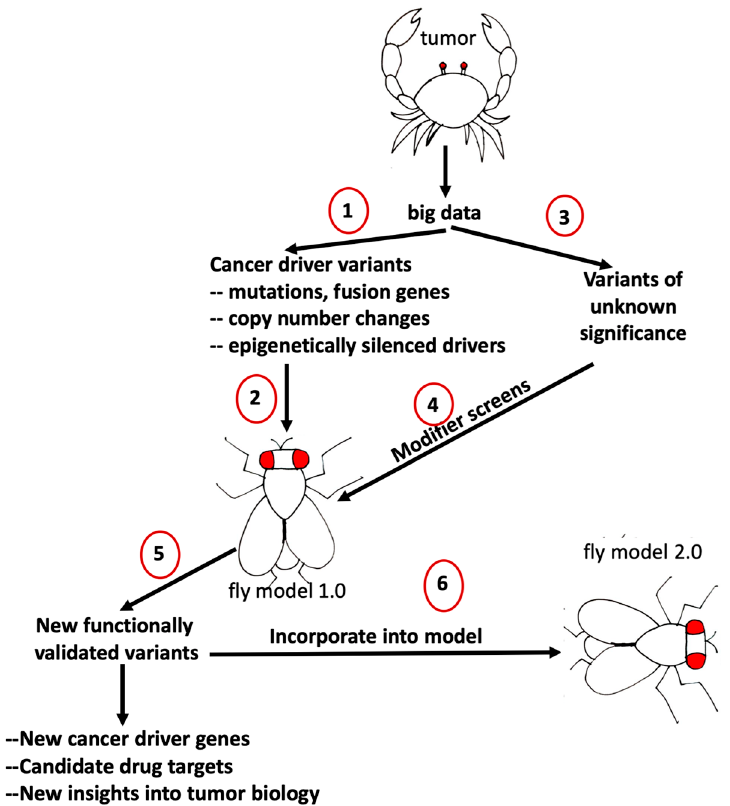
Figure 1. Functional exploration of tumor genome landscapes using tumor genome-based Drosophila cancer models. (1) A tumor genome dataset is mined to identify cancer driver mutations with previously established roles in tumorigenesis. (2) A Drosophila model that captures those alterations is established. (3,4) The Drosophila model used to screen variants with unknown significance to identify additional genes with potential roles in tumorigenesis. (5,6) Hits identified as modifiers of tumor phenotypes from the screen are incorporated into the Drosophila model to build a more complex and representative next generation model. Repeated rounds of model building and validation can be used to build increasingly complex models that better reflect the molecular landscape of sequenced tumors and find new variants.